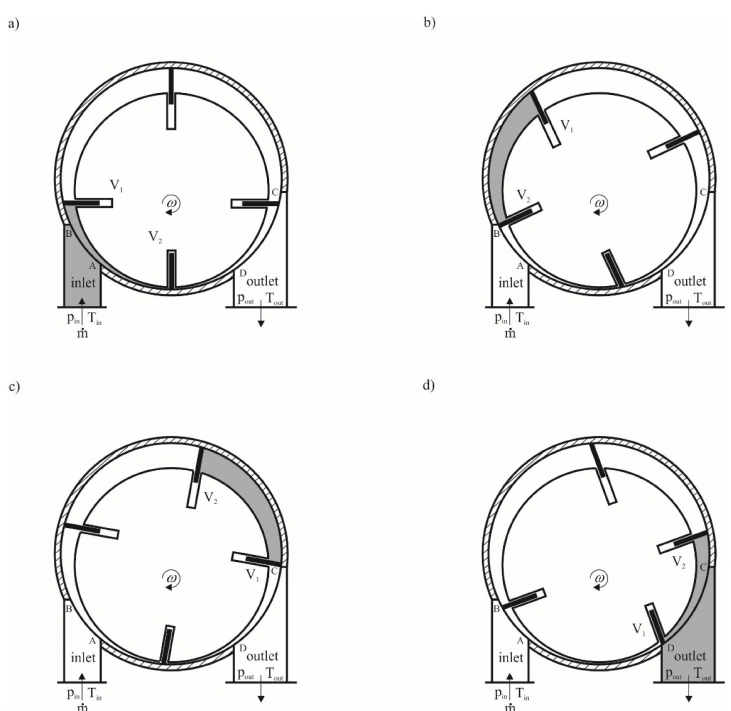
Figure 8. Working fluid expansion and rotary vane expander operation in the rotary vane expander: ( a ) filling process; ( b ) end of filling process; ( c ) end of expansion process; and ( d ) working fluid rejection process